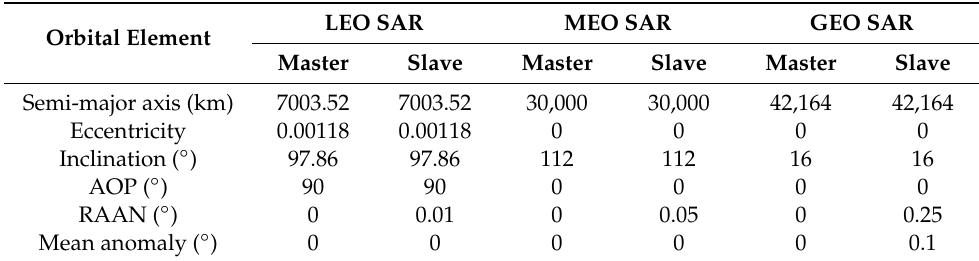
Figure 3. Angle between velocities in ECF and ECI coordinate. ( a ) Definition of the angle; ( b ) the angle in LEO SAR; ( c ) the angle in GEO SAR. Table 1. Orbital elements for simulation.